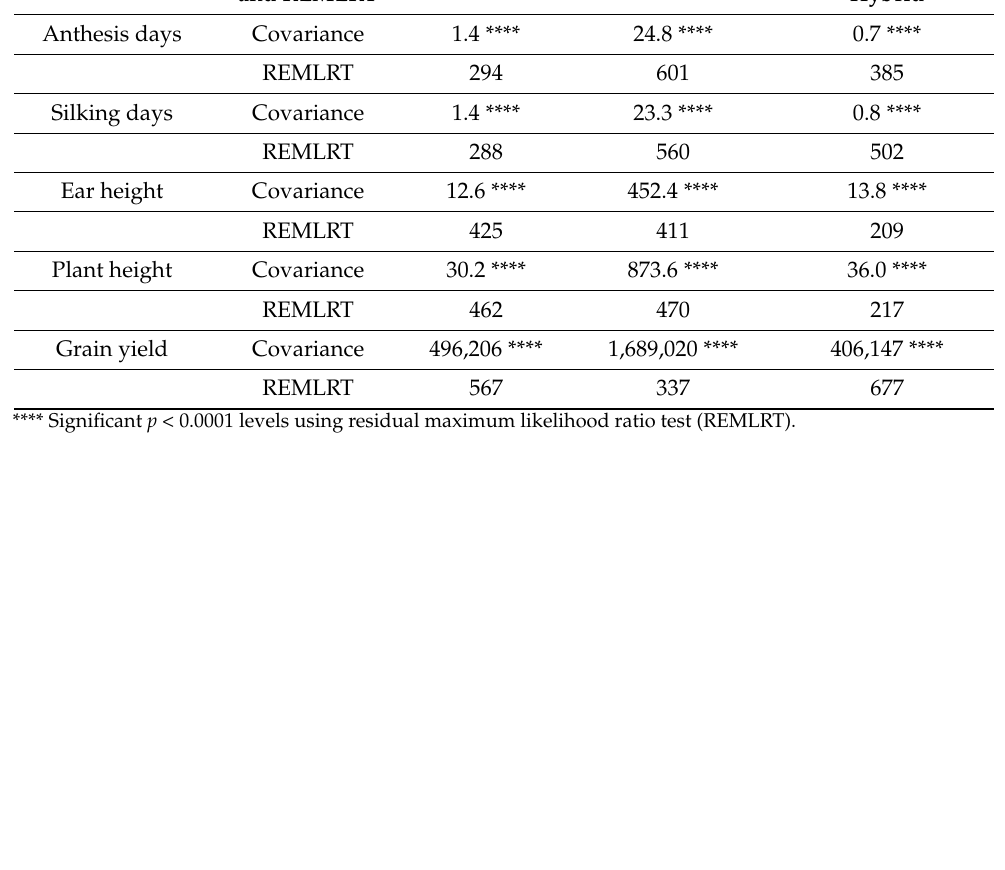
Table 4. Covariance estimates and their significant test for agronomic traits through the residual maximum likelihood ratio test (REMLRT) based on the combined analyses across environments. Covariance Traits Hybrid and REMLRT